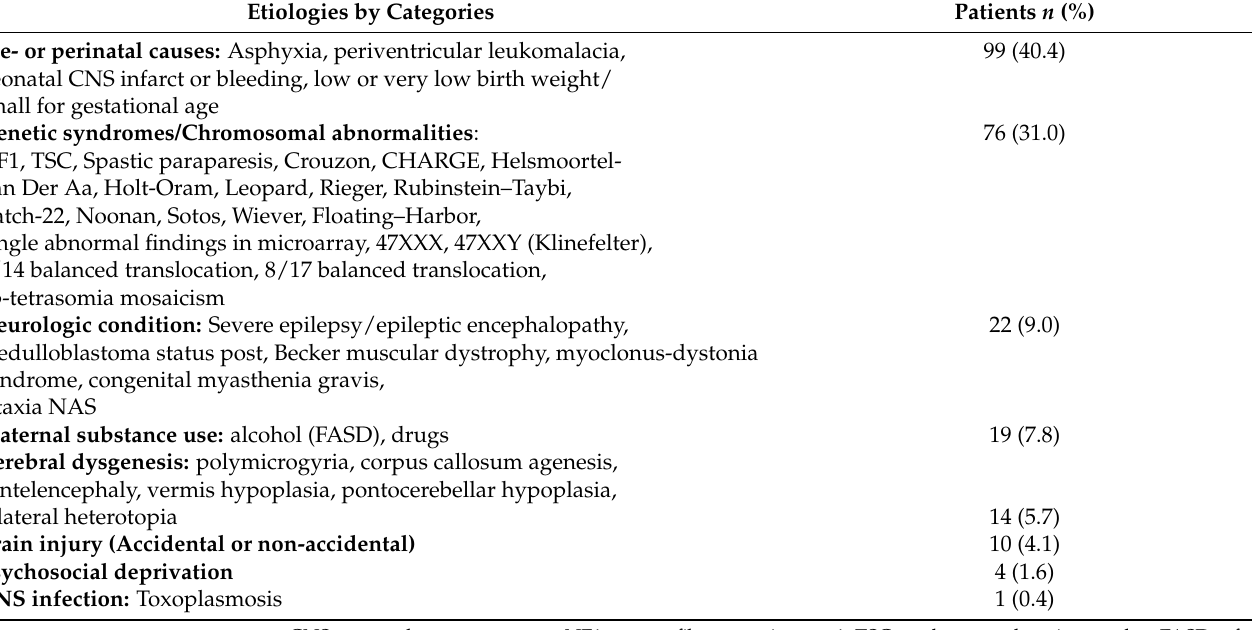
Table 1. Identified etiologies by categories ( n = 245).